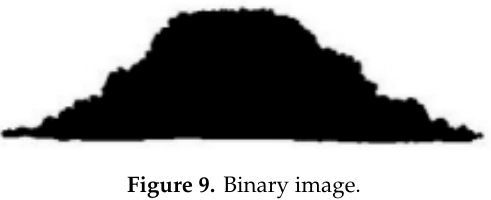
Figure 9. Binary image.